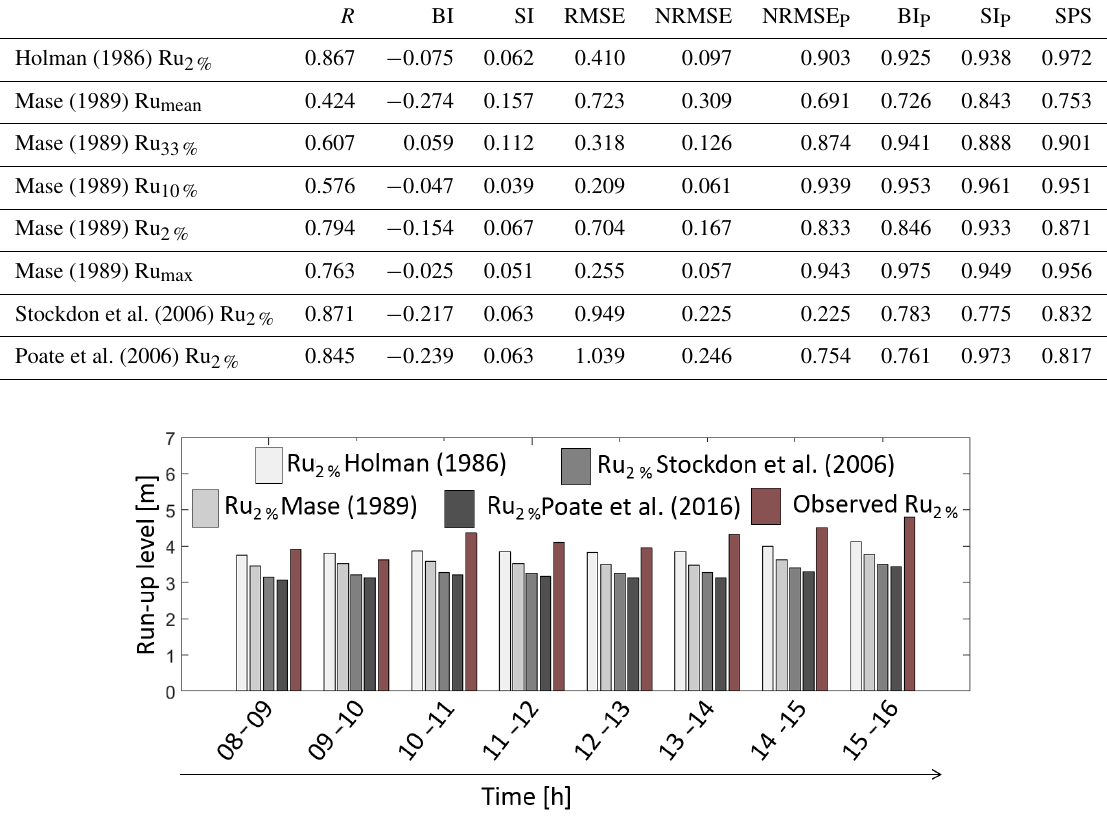
Figure 12. Hourly comparison (10 February 2016 from 08:00 to 16:00UTC) between observed and simulated Ru 2% . The run-up level simulations are carried out using the empirical formulas introduced by Holman (1986), Mase (1989), Stockdon et al. (2006) and Poate et al.